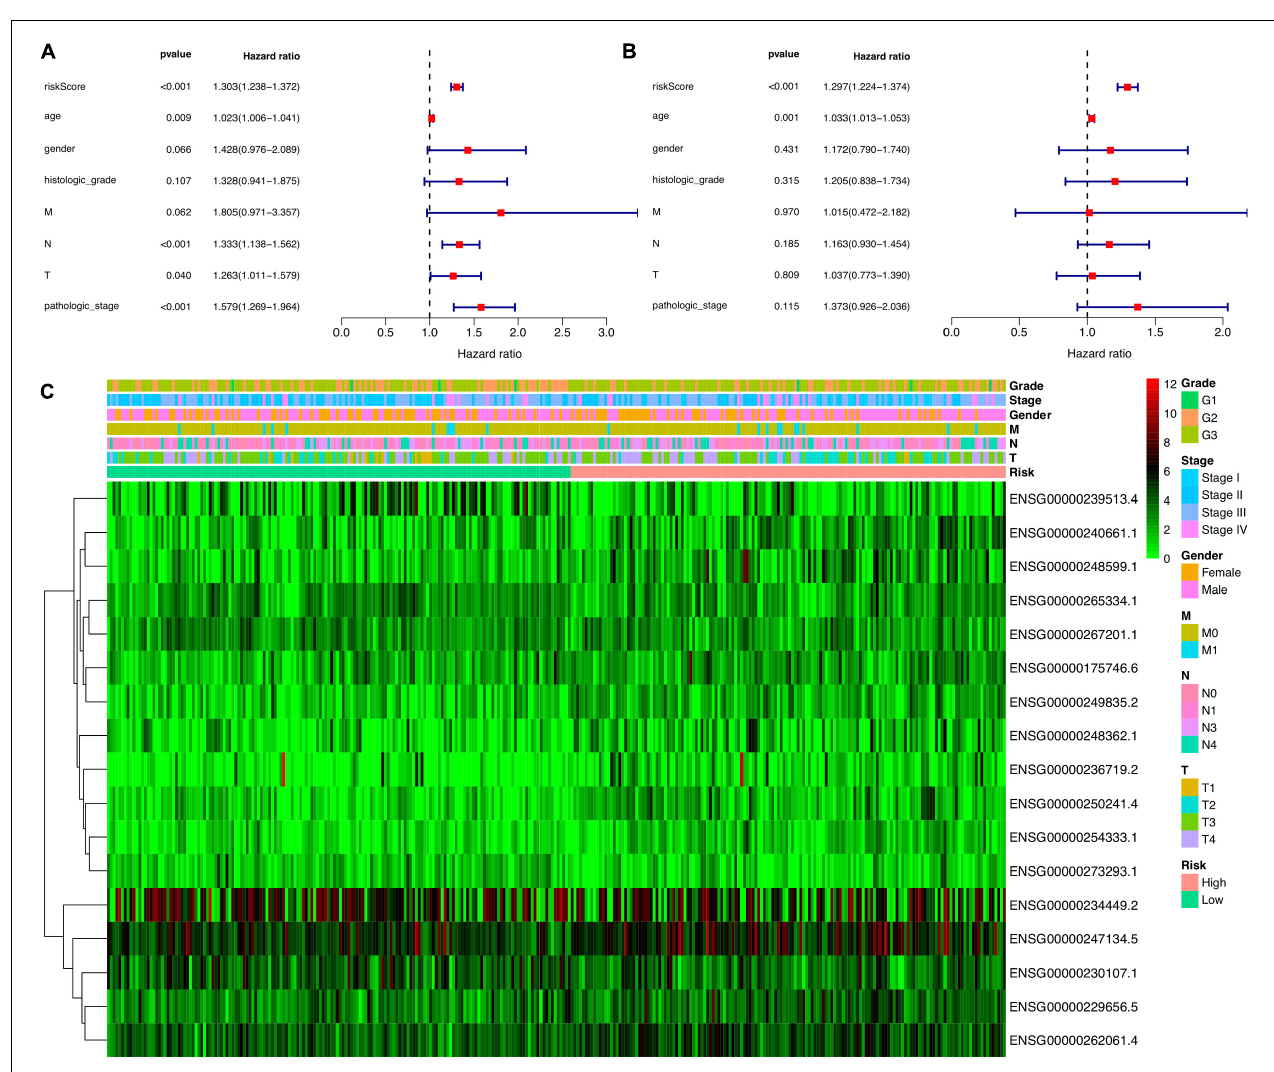
FIGURE 5 | Cox regression analysis for the clinical phenotypes of gastric cancer patients. (A) Forest plot for the overall survival (OS) prognostic values through univariate Cox regression analysis. (B) Forest plot for the OS prognostic values through multivariate Cox regression analysis. (C) Relationship heatmap of the risk scores and clinical phenotypes of